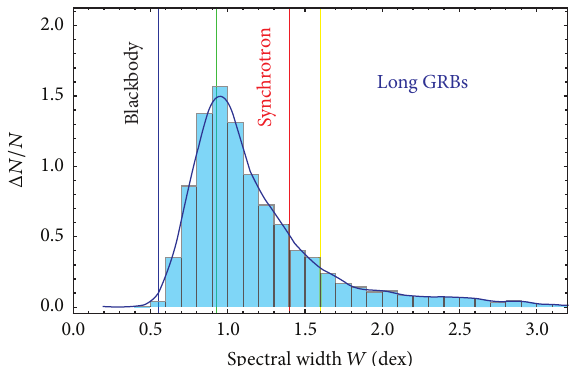
Figure 8: Full width half maximum of the spectral peaks of over 2900 bursts fitted with the “Band” function. The narrow most spectra are compatible with a “Planck” spectrum. About ∼ 80% of the spectra are too narrow to be fitted with the (slow cooling) synchrotron emission model (red line). When fast cooling is added, nearly 100% of the spectra are too narrow to be compatible with this model. As it is physically impossible to narrow the broadband synchrotron spectra, these results thus suggest that the spectral peak is due to some widening mechanism of the Planck spectrum, which are therefore pronounced (indirectly) in the vast majority of spectra. Figure taken from Axelsson and Borgonovo